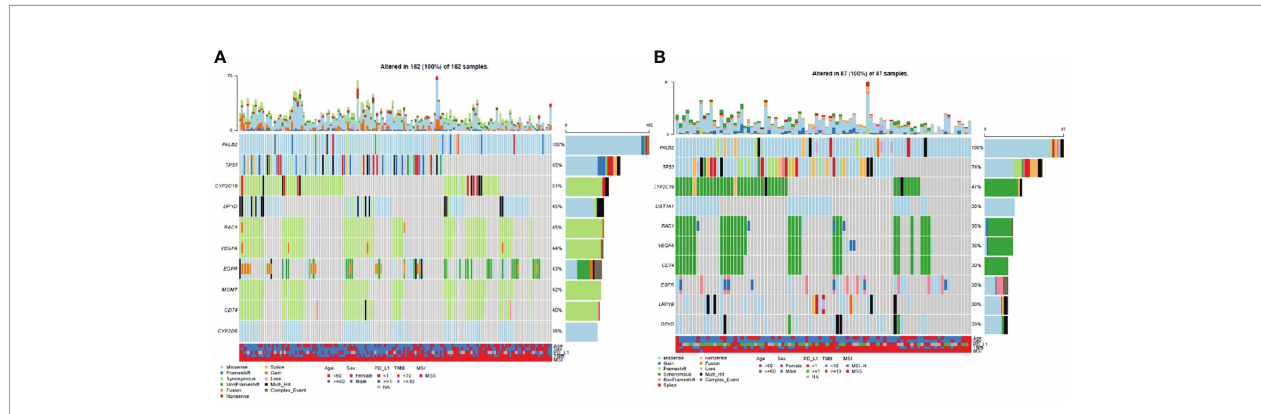
FIGURE 2 | Waterfall plot (oncoplot) of variants in NSCLC patients with PALB2 mutations, including (A) germline mutations and (B) somatic mutations.